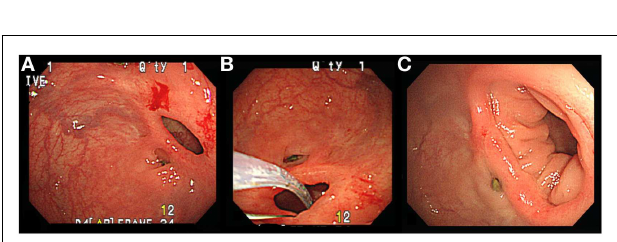
FIGURE 2 | (A) Stricture of anastomosis. (B) Using Sphincterotomes to release the circumferential scar. (C) Increased the diameter of anastomosis.